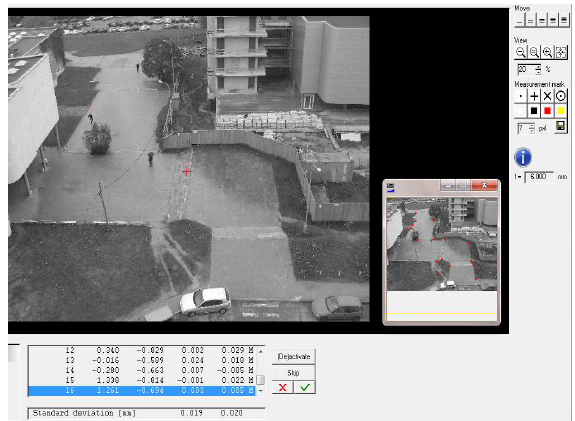
Figure 4. Experimental images – stereo pair